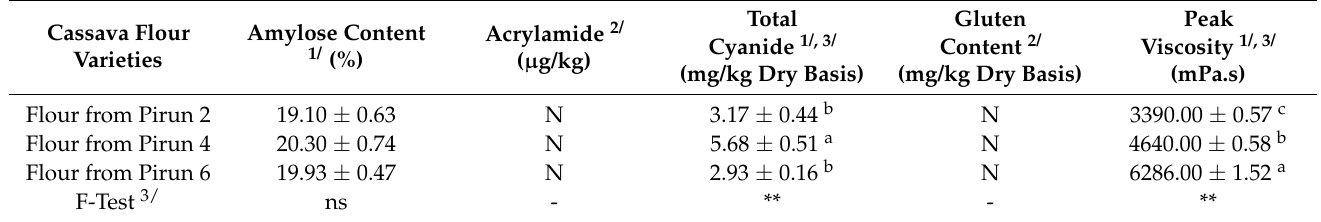
Table 2. Amylose content, acrylamide, cyanide content, and viscosity from difference varieties of cassava